Question: According to the figure, is the described quantity increasing or decreasing?
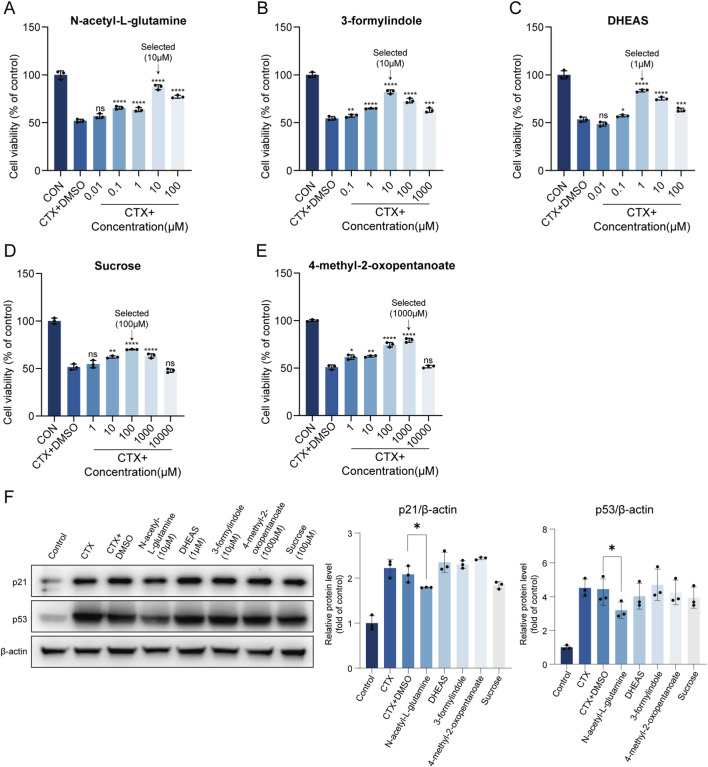
Answer: increasing